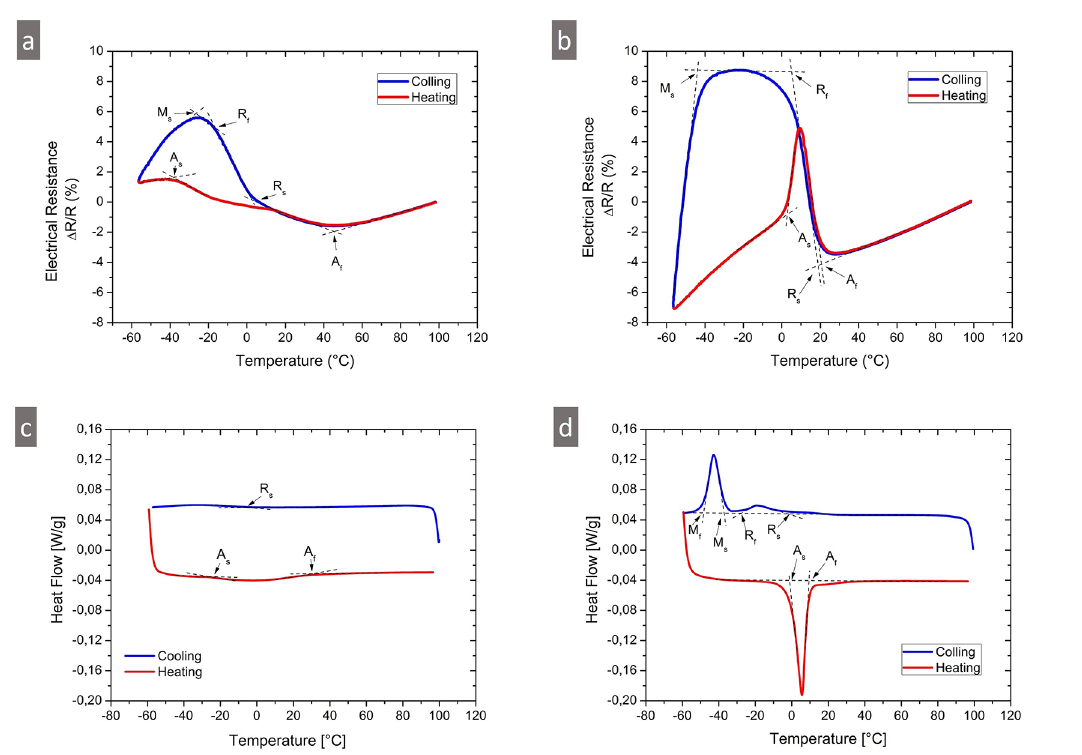
Figure 3. DSC and ERT behaviours for the SPG-D2.0 spring. a) ERT as-cast. b) ERT heat treated. c) DSC as-cast. d) DSC heat